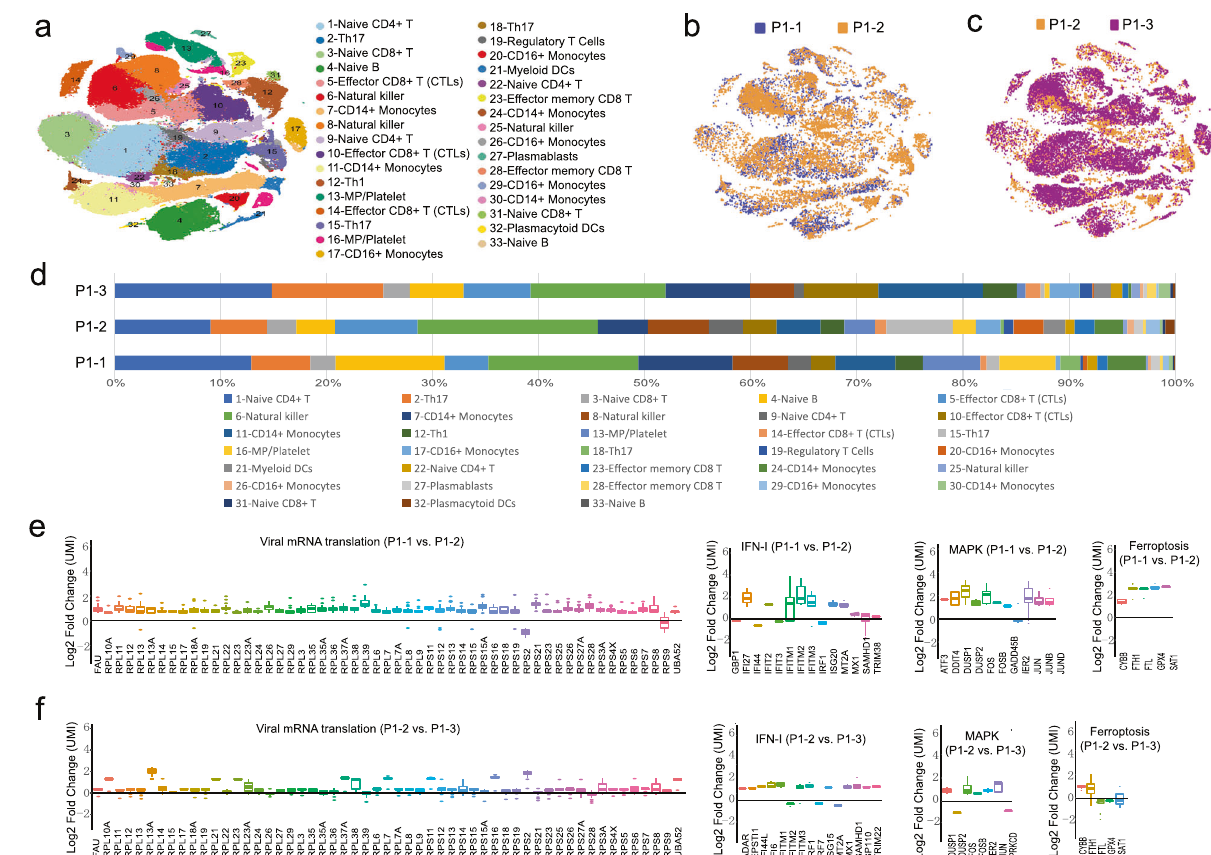
Fig. 3 The dynamic study for critical patient 1 before and after improvement. a TSNE plots of cell types identi fi ed in patients with dynamic study (P1-1, P1-2, P1-3, P2-1, P2-2,m P2-3, P3-1, P3-2,P6-1, P6-2, P7-1, P7-2, P9-1, P9-2, P10-1, and P10-2). b TSNE plots of P1-1 (in critical condition) and P1-2 (in improvement condition), showing the cell type distribution in the two samples. c TSNE plots of P1-2 and P1-3 (in cured condition), showing the cell type distribution in the two samples. d Comparisons of all the cell subtypes of P1-1, P1-2, and P1-3. e Log2 fold changes of the UMI counts of the genes involved in viral mRNA translation, IFN-I, MAPK targets, and ferroptosis between P1-1 and P1-2. Each point represents a different cell subtype. f Log2 fold changes of the UMI counts of the genes involved in viral mRNA translation, IFN-I, MAPK targets, and ferroptosis between P1-2 and P1-3. Each point represents a different cell